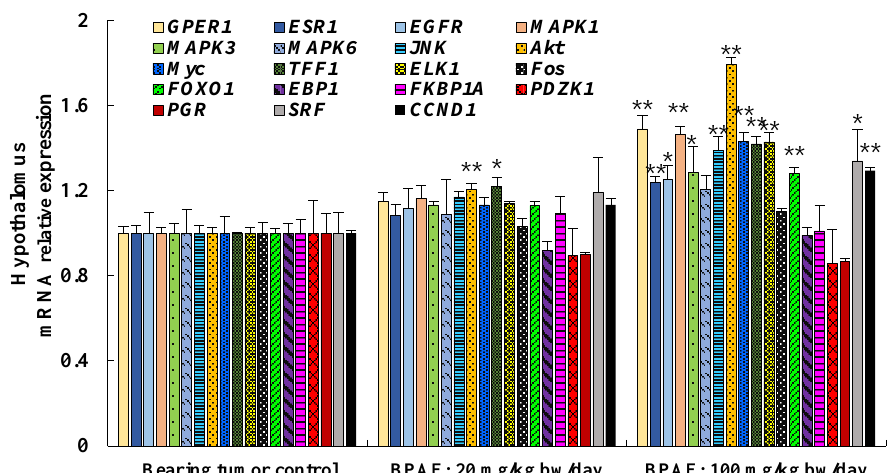
Figure 2. Effect of BPAF exposure for 15 days on the mRNA relative expression of 19 genes associated with the PI3K/Akt and MAPK pathways in hypothalamus of female nude mice with SK-BR-3 xenograft tumor. The data showed the mean ± SD of six parallel mice samples. * p < 0.05 and ** p < 0.01, relative to SK-BR-3 bearing tumor control. Note: GPER1: G protein-coupled estrogen receptor 1; ESR1: estrogen receptor alpha; EGFR: epidermal growth factor receptor; MAPK: mitogen-activated protein kinase; JNK: c-Jun N-terminal kinase; Akt: protein kinase B; Myc: myc proto-oncogene; TFF1: trefoil factor 1; ELK1: ETS domain-containing protein; Fos: fos proto-oncogene; FOXO1: forkhead box O1; EBP1: ErbB-3 binding protein 1; FKBP1A: FK-506 binding protein 1A; PDZK1: PDZ domain protein kidney 1; PGR: progesterone receptor; SRF: serum response factor; CCND1: cyclin D1.